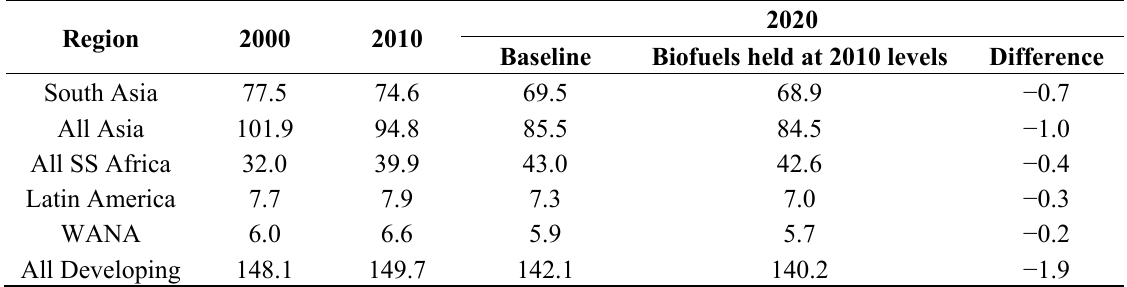
Table 2. Child malnutrition levels under baseline and scenario (undernourished children aged 0–5,